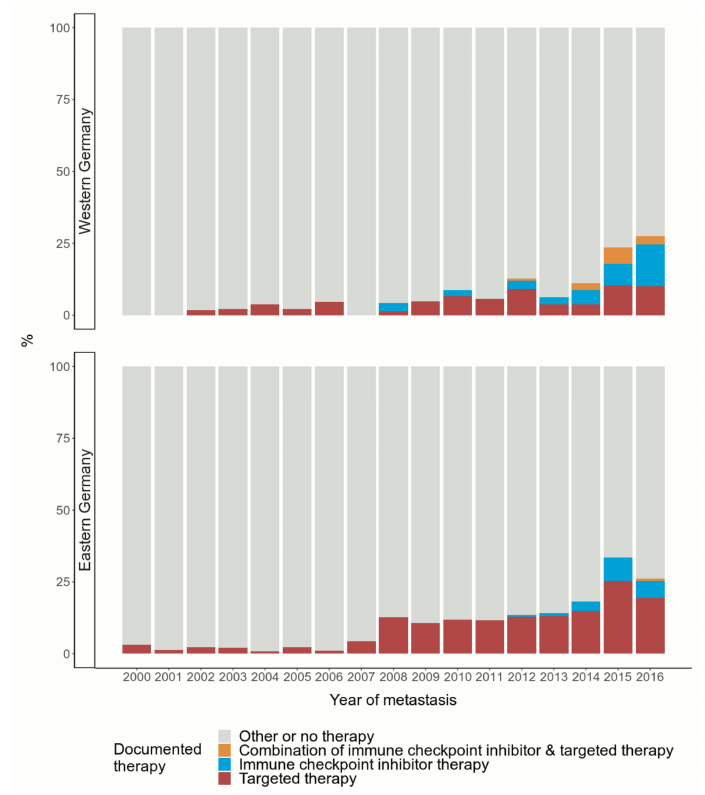
Figure 1. Documented application of immune checkpoint inhibitor therapy and targeted therapy over time during the 2000–2016 observation period stratified by region. Number of patients: n = 3871 ( n = 1080 in Western Germany; n = 2791 in Eastern